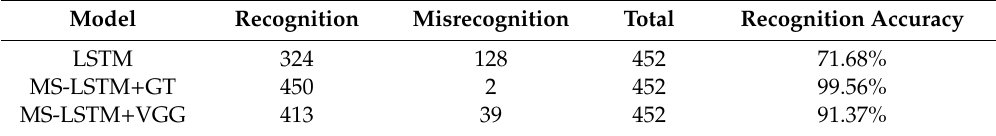
Table 5. Performances of the 3 networks with respect to the ‘fake conflict’ samples in validation set. Model